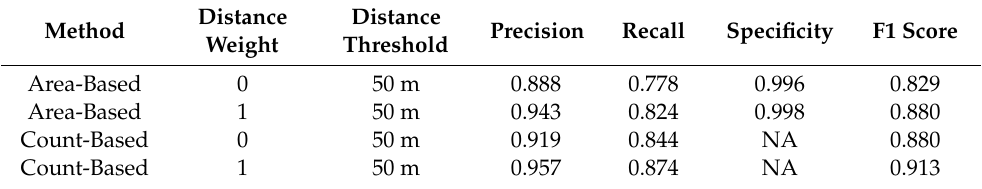
Table 6. Assessment results for extraction of valley fill faces using deep learning.